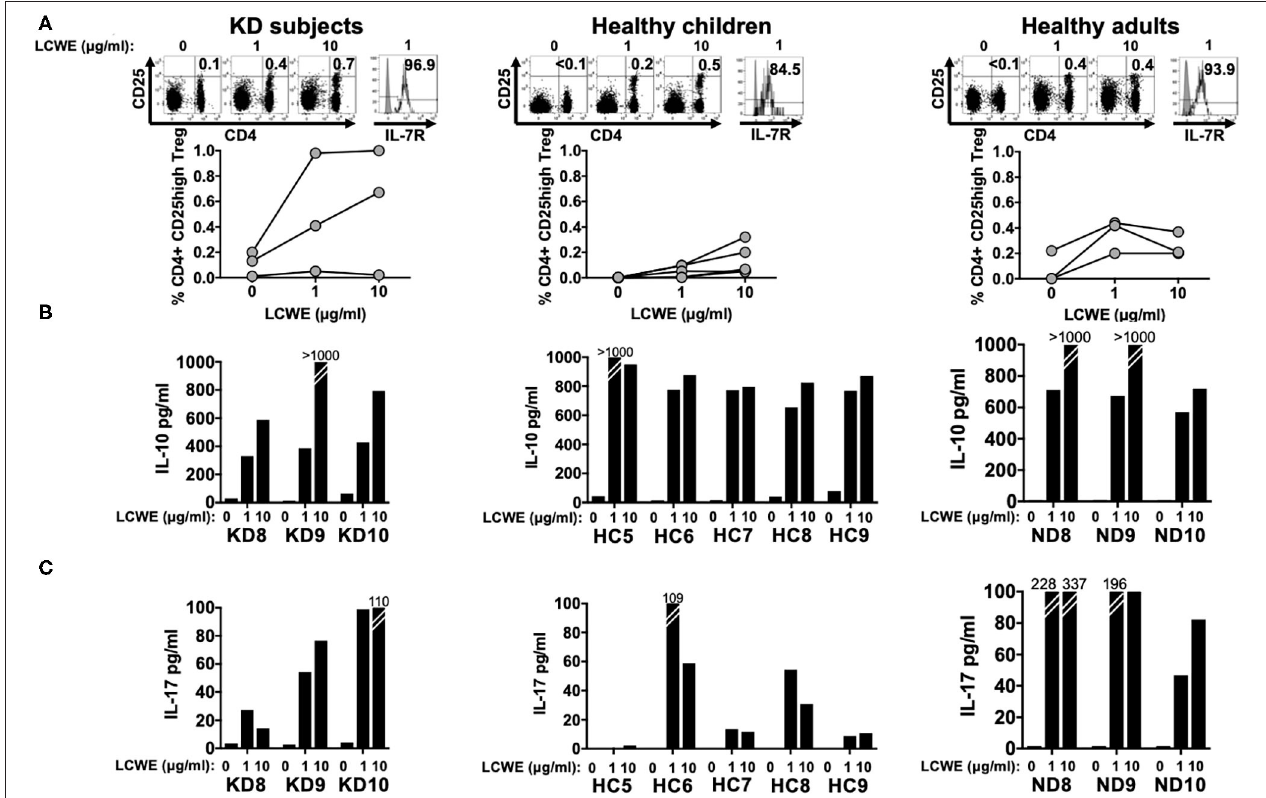
FIGURE 3 | CD4 + CD25 high Treg expansion in response to LCWE. To address peripherally-induced Treg responses to LCWE, we studied CD4 + CD25 high Treg expansion in PBMC stimulated with 1 and 10 µ g/ml of LCWE for 4 days in 3 subacute KD subjects 3 weeks after disease onset (KD8–10, Table 1 ), 5 healthy children (HC5–9, Table 1 ), and 3 healthy adults (ND8–10, Table 1 ). Unstimulated PBMC served as control (A) Representative CD4 + CD25 high T cell enumeration and IL-7R expression is shown. Gray: un-stained control. Culture supernatants derived from the same PBMC cultures were tested for IL-10 (B) and IL-17 (C) secretion by ELISA. The statistical differences of the Treg responses between cohorts were tested by one-way ANOVA. A P < 0.05 was considered significant. The results suggested that LCWE stimulates Treg (1 µ g/ml, p = 0.0974; 10 µ g/ml, p = 0.1960) in the 3 cohorts with no statistical